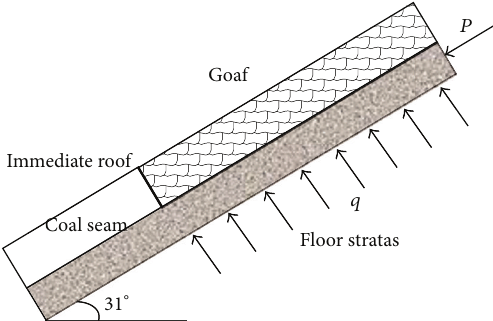
Figure 1: Composition schematic illustration of rock beam-pillar structure model.